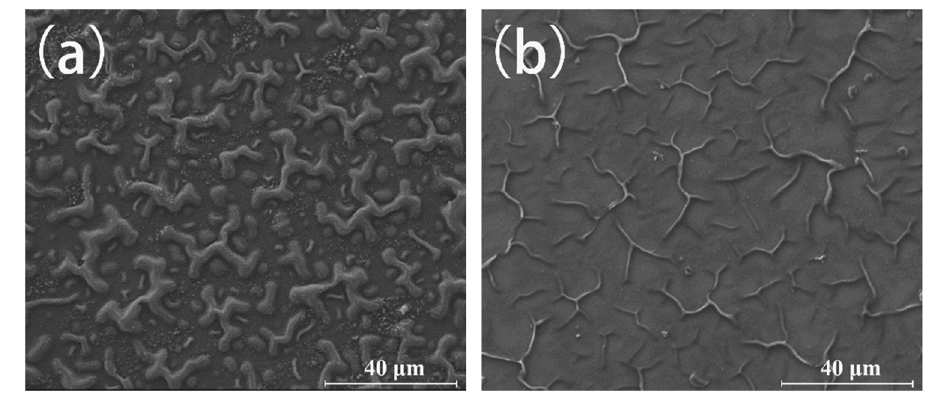
Figure 3: SEM micrographs of ( a ) PEDOT:PSS/EMI - TFSI and ( b ) PEDOT:PSS deposited at 1.4 V for 40 s.